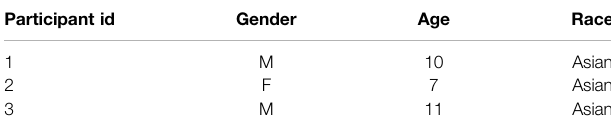
TABLE 2 | Demographic information for the participants of the user